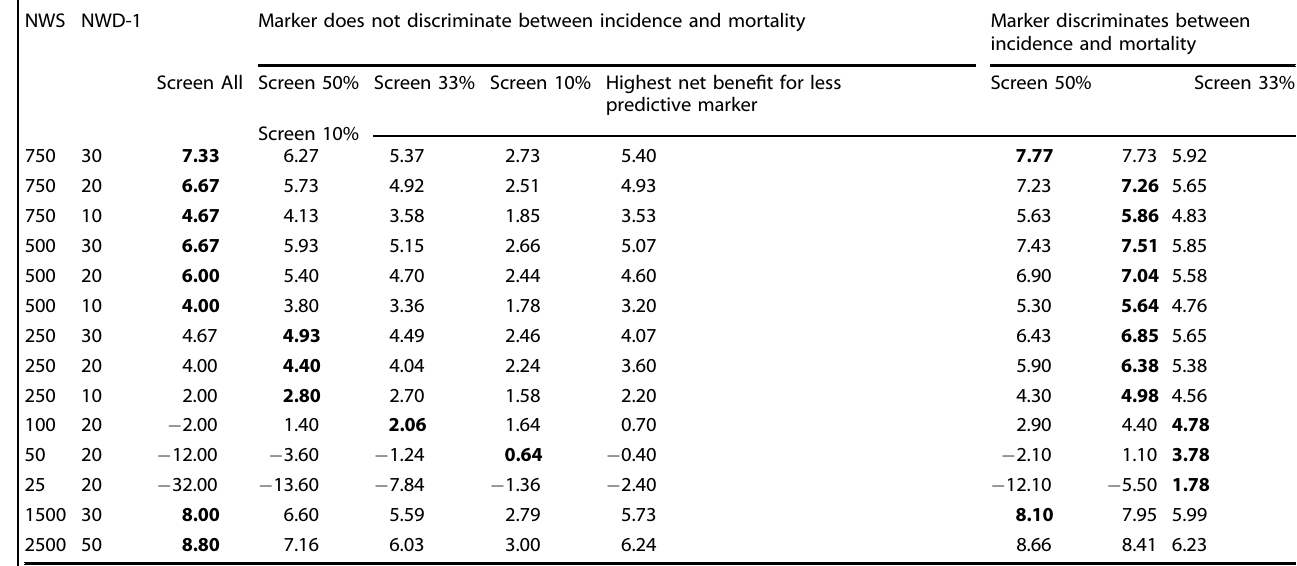
Bold values denote the strategy with the highest net bene fi